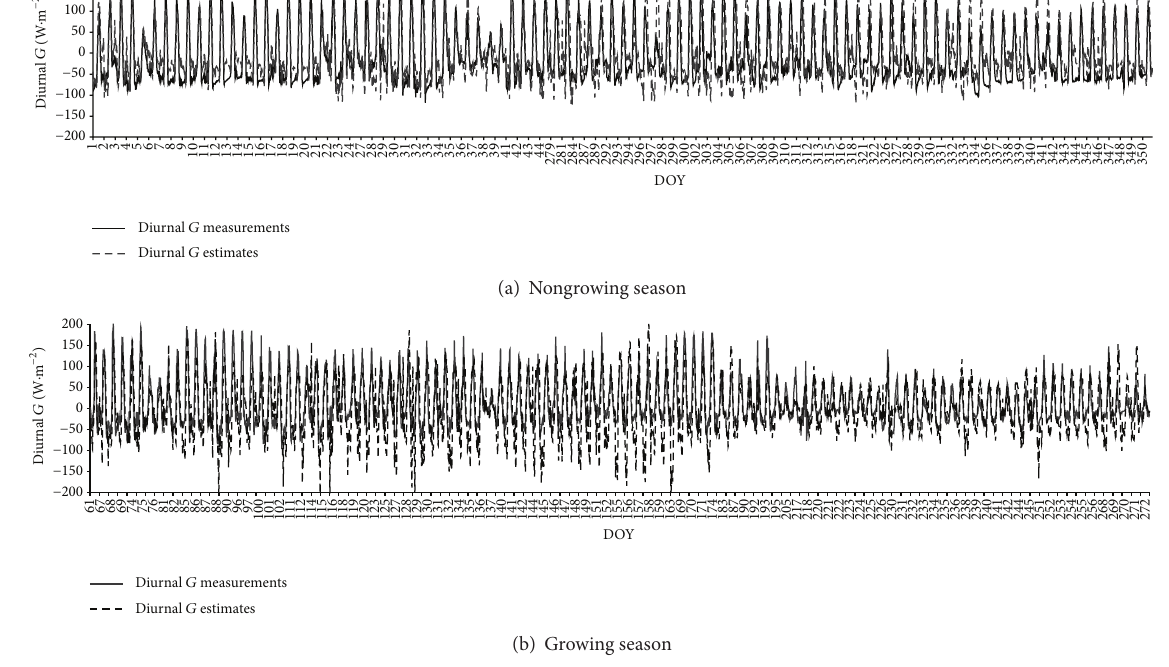
Figure 4: The diurnal course of 𝐺 estimates and 𝐺 measurements for the nongrowing season (a) and for the growing season (b).